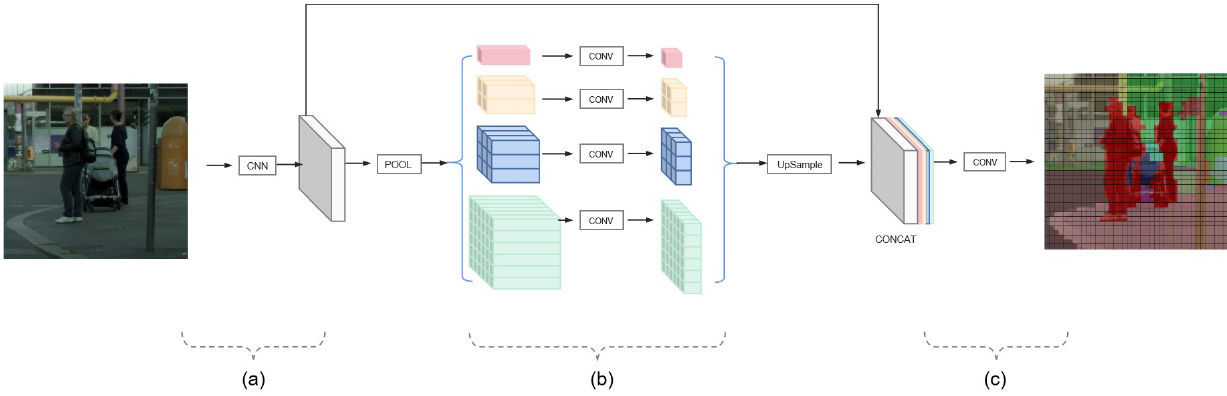
Figure 5. The sample points for downloading street view images of Gulou.